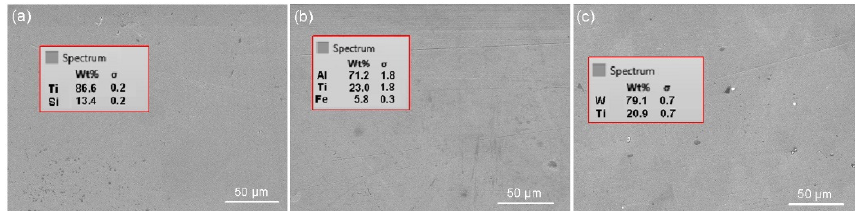
Figure 2. Micrographs (1000×) of the ( a ) TiSi, ( b ) AlTi, and ( c ) WTi coatings. Elemental composition analysis results (% by weight) obtained via EDS.